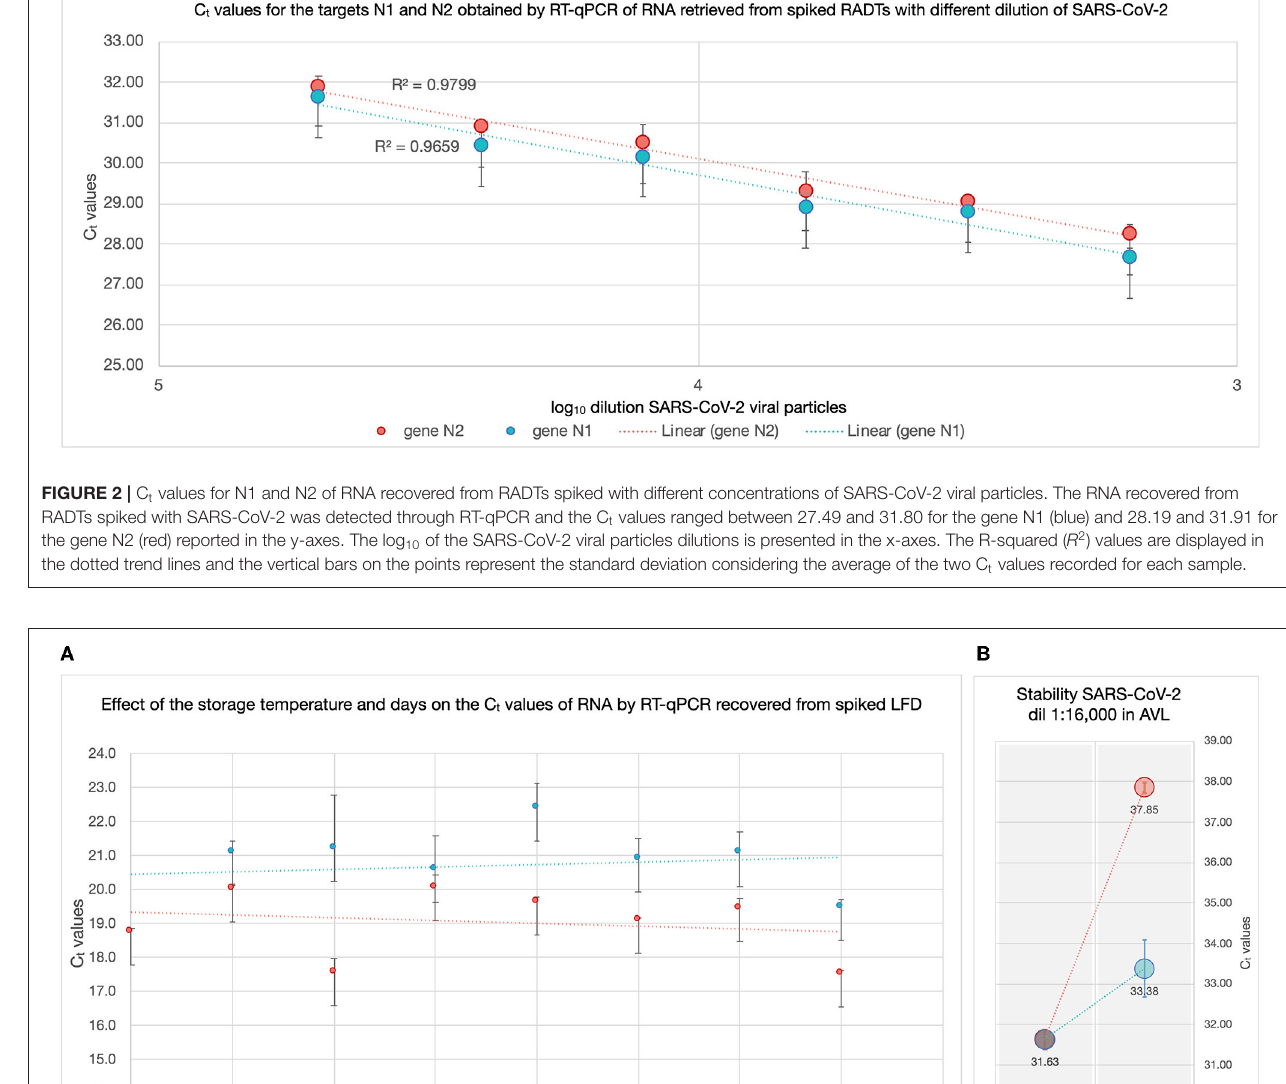
of viral RNA by RT-qPCR when RADTs were inoculated with the 1:16,000 dilution (C t = 31.63) at day 7. Low amounts of RNA in RADTs appear to be more stable when incubated at 4 ◦ C (C t = 33.38) compared to 20 ◦ C (C t = 37.85) ( Figure 3B ). A total of four RNA samples extracted from RADTs from the stability test were sequenced, including two